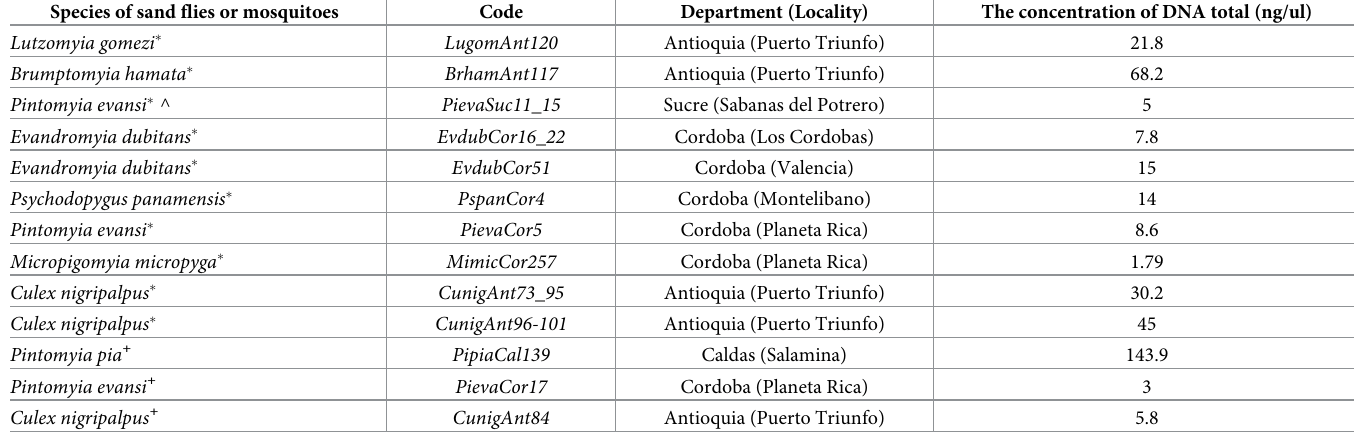
Table 2. Samples of phlebotomine sand flies and mosquitoes that were positive for endosymbionts ( Wolbachia � ; Cardinium^ , Microsporidia + ) by PCR previously and selected for analysis of the total microbiota by Illumina MiSeq sequencing. Species of sand flies or